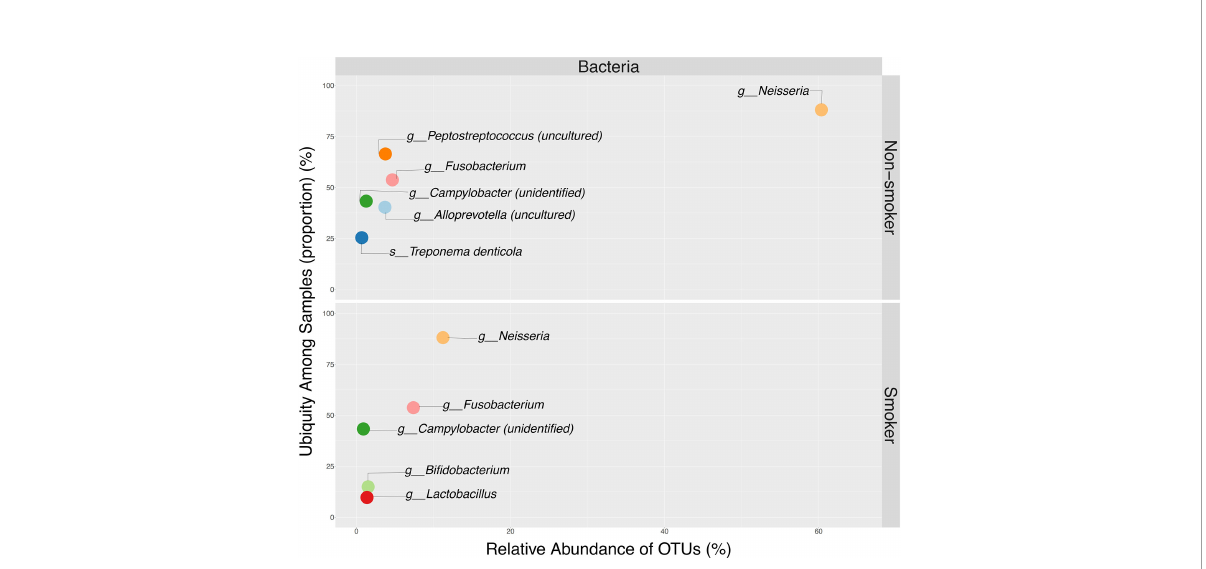
FIGURE 8 Ubiquity dot plot illustrating bacterial OTUs dominance in the oral cavity, according to their relative abundance (x-axis) and ubiquity (y-axis) by smoking status. Ubiquity was calculated by converting the OTU table into a simple column, to depict relative abundance and ubiquity using reshape2 package. Illustration of the dot plot was obtained using ggplot2 package available